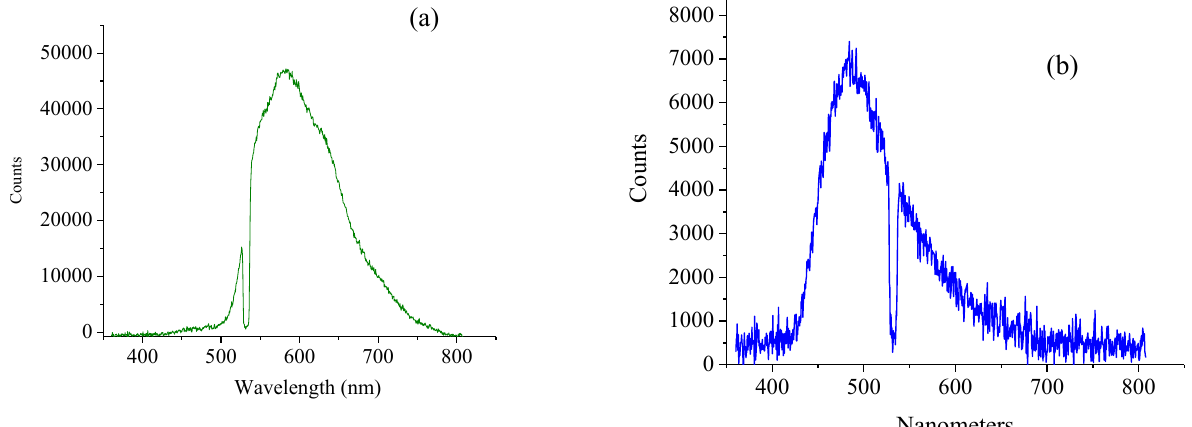
Figure 3. Spectra of the fluorescence of the spherical modifications by ( a ) green laser (514 nm) and ( b ) ultraviolet laser (266 nm).